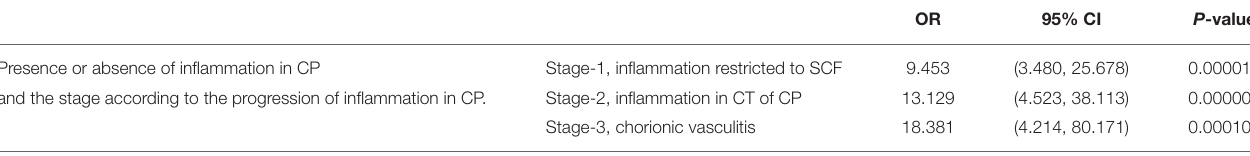
OR 95% CI P -value